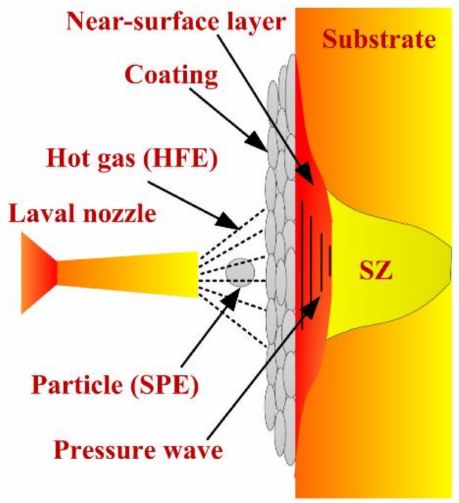
Figure 22. Schematic diagram of cold spraying process [57].